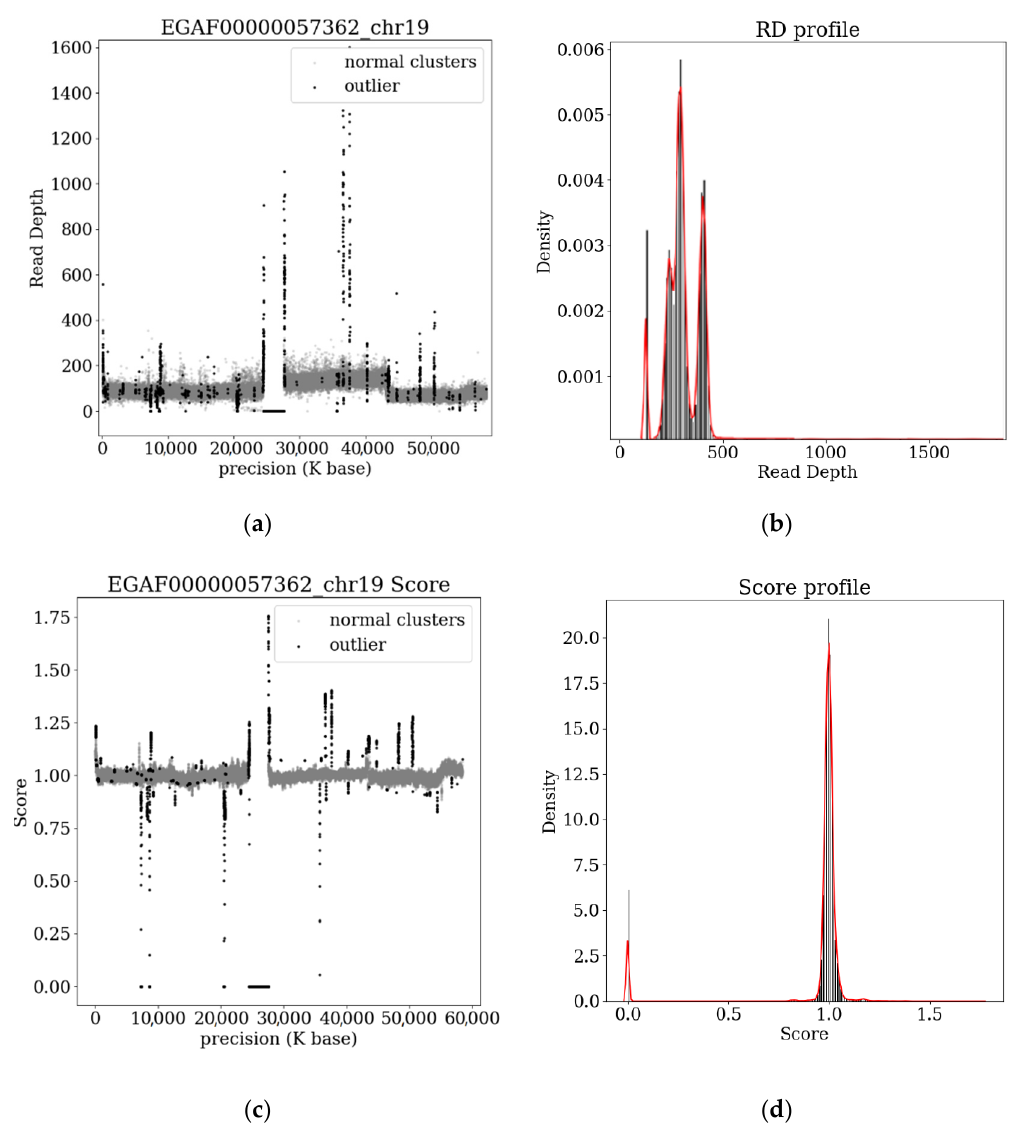
Figure 2. The clustering result of chromosome 19 in sample EGAF00000057362. ( a ) RD–position diagram shows the RD of each bin. The gray dots represent the bins in the normal cluster, and the black dots represent the bins in the abnormal cluster, also known as an outlier. ( b ) RD vs. frequency distribution curve. ( c ) This chart shows the score of each bin, in which the uneven RDs have been corrected. ( d ) Fractional frequency distribution diagram. By correcting the uneven RDs and unbalanced amplitudes, the normal distribution is able to fit the scores of all bins.